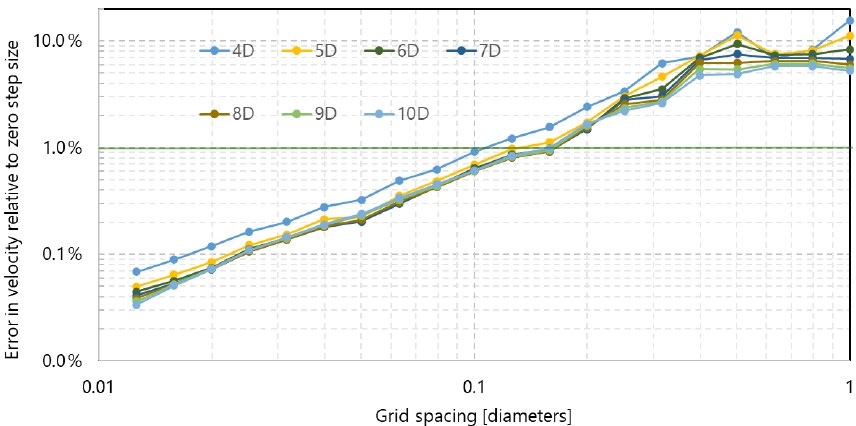
Figure 2. Numerical error due to the grid spacing, based on the difference in wind speed from the hypothetical zero grid spacing value calculated by Richardson extrapolation. The scenario assessed has an ambient wind speed of 8ms − 1 and c t = 0 . 8, neutral atmospheric stability and 10% turbulence. The acceptable numerical error is shown as 1%.